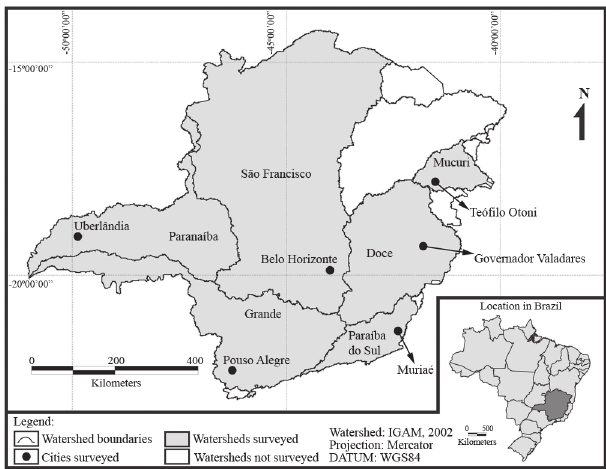
Fig. 1. Cities and watersheds within the Minas Gerais State, Brazil, where the 39 ornamental fish stores were